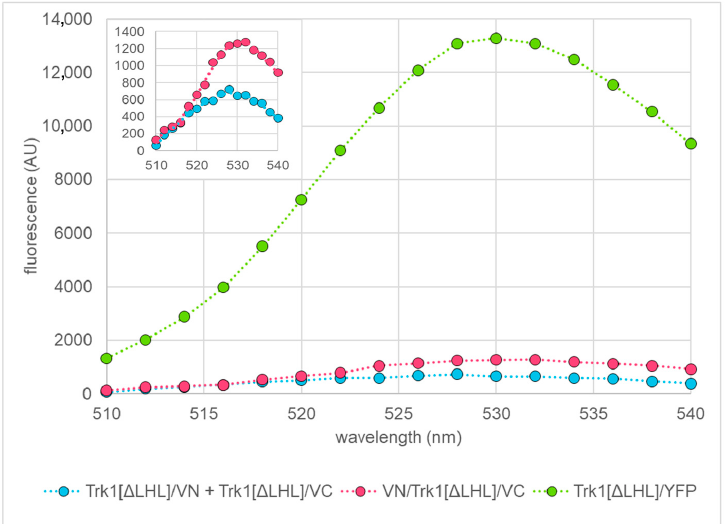
Figure 7. Quantification of BiFC . Representative BiFC fluorescence spectra of yeast cells grown in medium with 1 mM KCl and possessing the indicated Trk1[ Δ LHL] fusion proteins. Spectra were recorded in the late exponential phase (OD ~ 2.5; growth time: 14 h). The spectra of Trk1[ Δ LHL]/VN + Trk1[ Δ LHL]/VC, and VN/Trk1[ Δ LHL]/VC are magnified in the inset for better visibility.